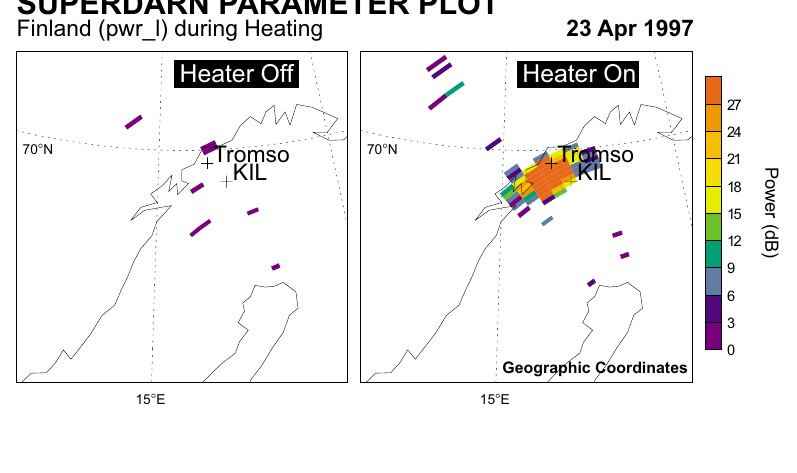
Fig. 2. Scans of CUTLASS Finland backscatter power indicating the effect of activating the heater. A large patch of artificial backscatter is generated in the radar’s field of view above Tromsø which would not otherwise have been present. Backscatter powers often ex- ceed 30dB above the noise. The loca- tion of the Kilpisj¨arvi pulsation magne- tometer (KIL) is also